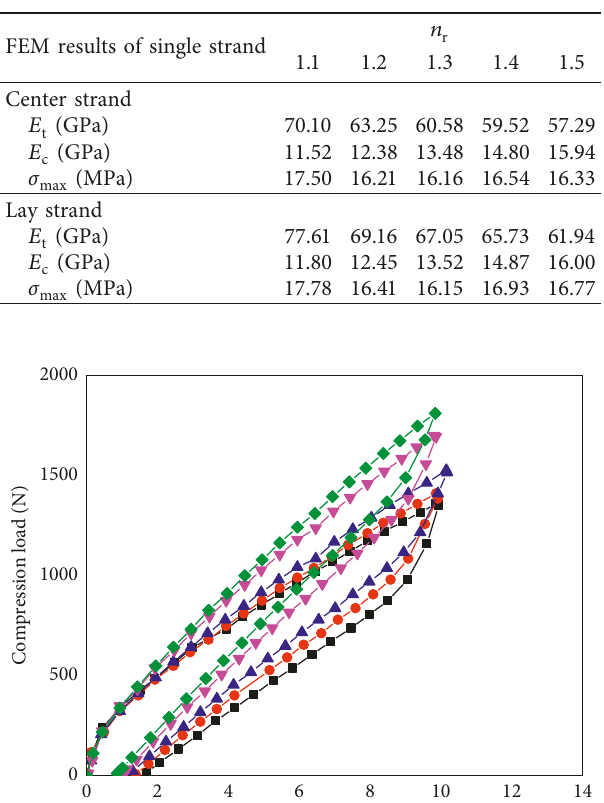
Figure 2: WRI structure: (a) GGQ-99 WRI; (b) simplified model of 6 × 19 IWS wire ropes. Table 1: Material parameters of the kinematic hardening model for Table 3: The mechanical parameters of single strands with different the arc wire rope [24]. diameter ratios.